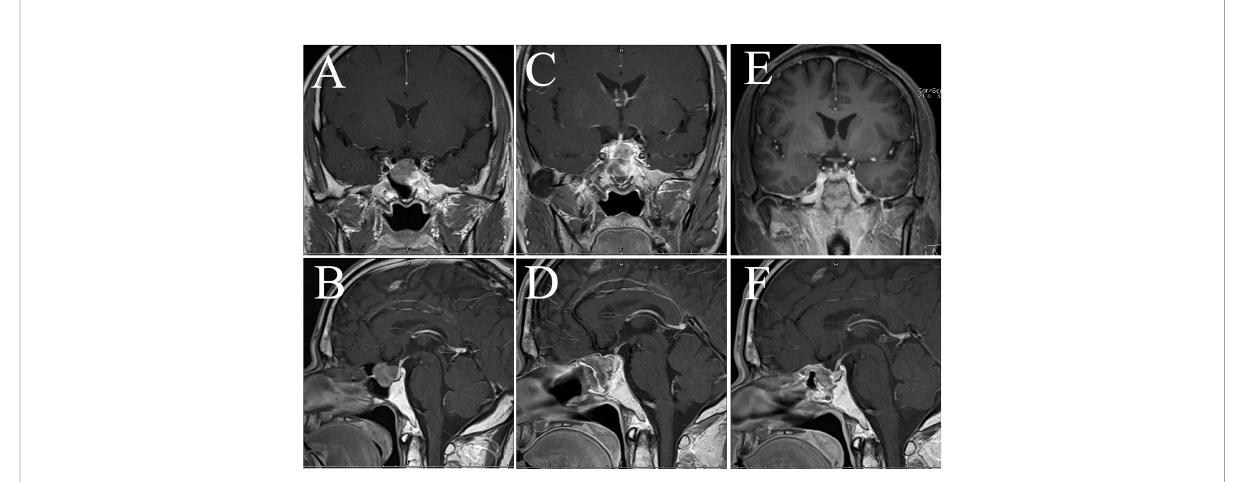
FIGURE 6 MRI examination of case 3. The images show coronal and sagittal MRI of the patient ’ s head preoperatively (A, B) , one week postoperatively (C, D) , and three months postoperatively (E, F) ,